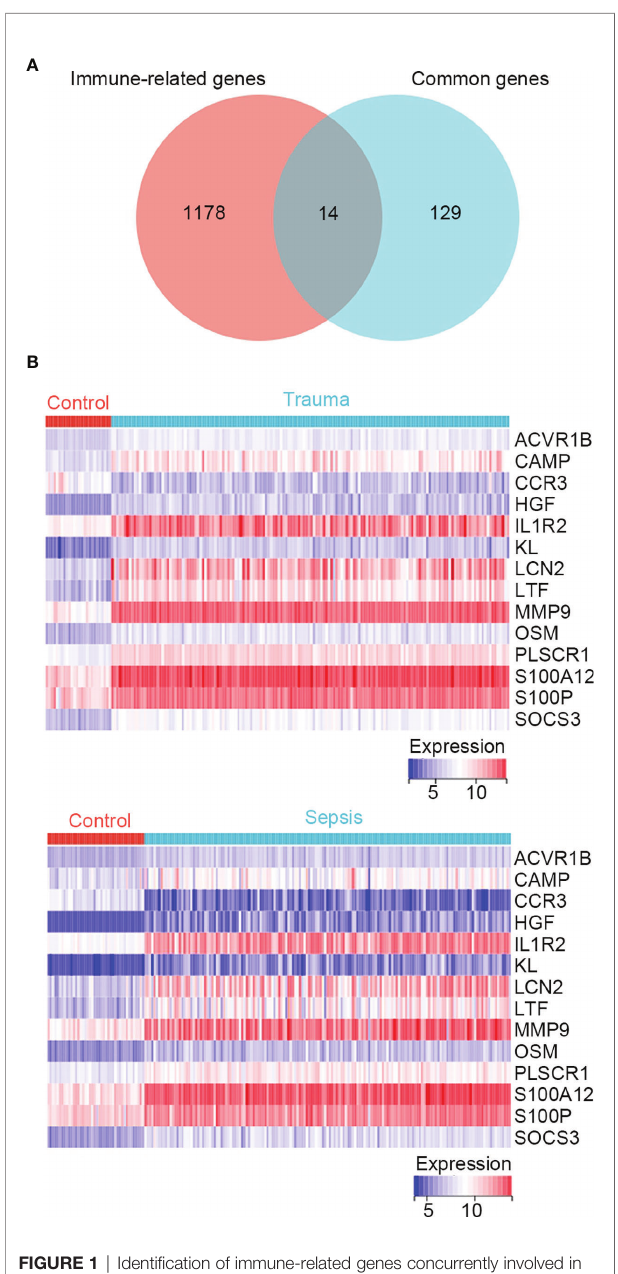
FIGURE 1 | Identi fi cation of immune-related genes concurrently involved in trauma and sepsis. (A) The Venn diagram of genes between the immune- related genes and the identi fi ed common genes. A total of 14 overlapping immune-related common genes were detected. (B) Expression pro fi les of the 14 immune-related common genes in trauma and